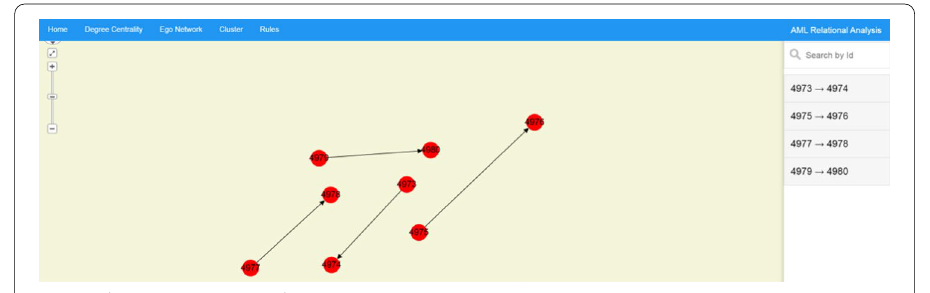
Fig. 9 Rule 1: Common